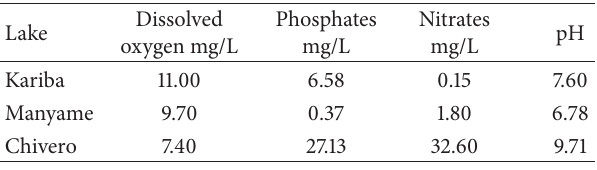
Table 2: Quality of water from Lakes Chivero, Manyame, and